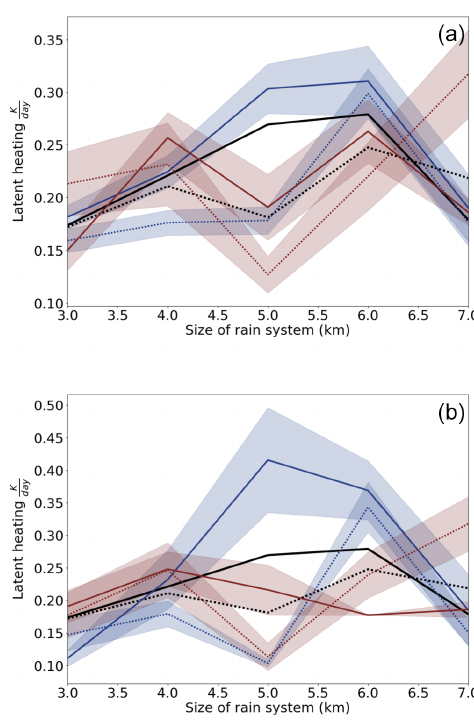
Figure A1. Figure 2 with ± standard error